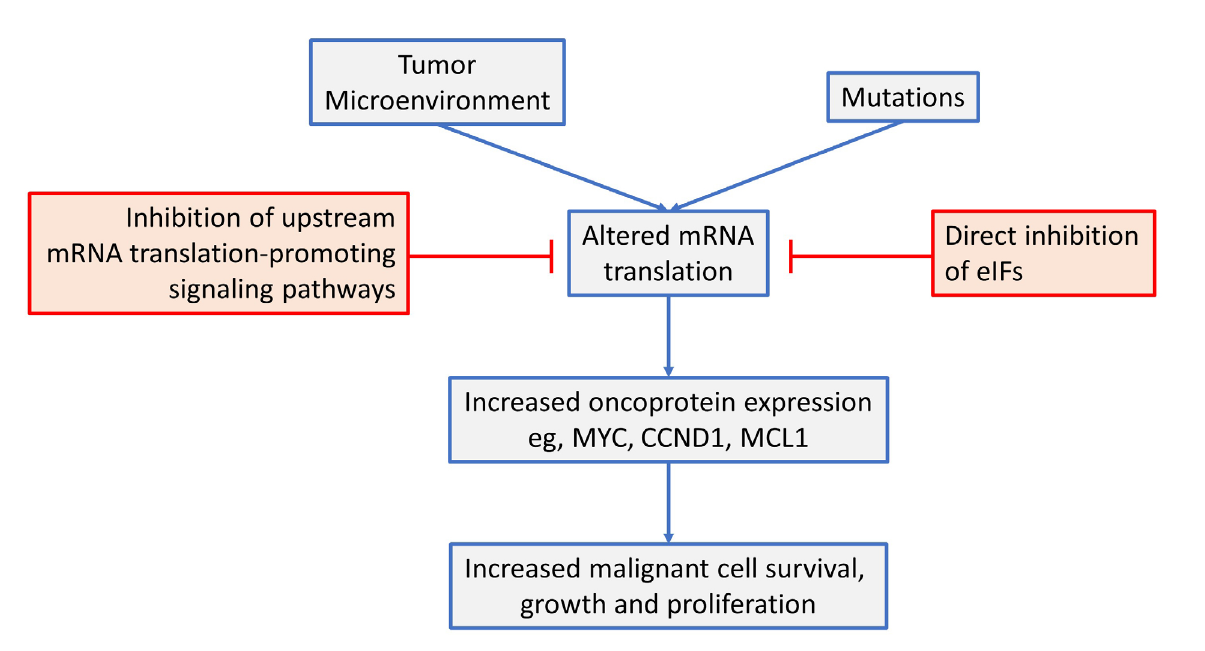
Figure 4. An overview of mRNA translation initiation dysregulation in B-cell neoplasms and its targeted inhibition. See text for